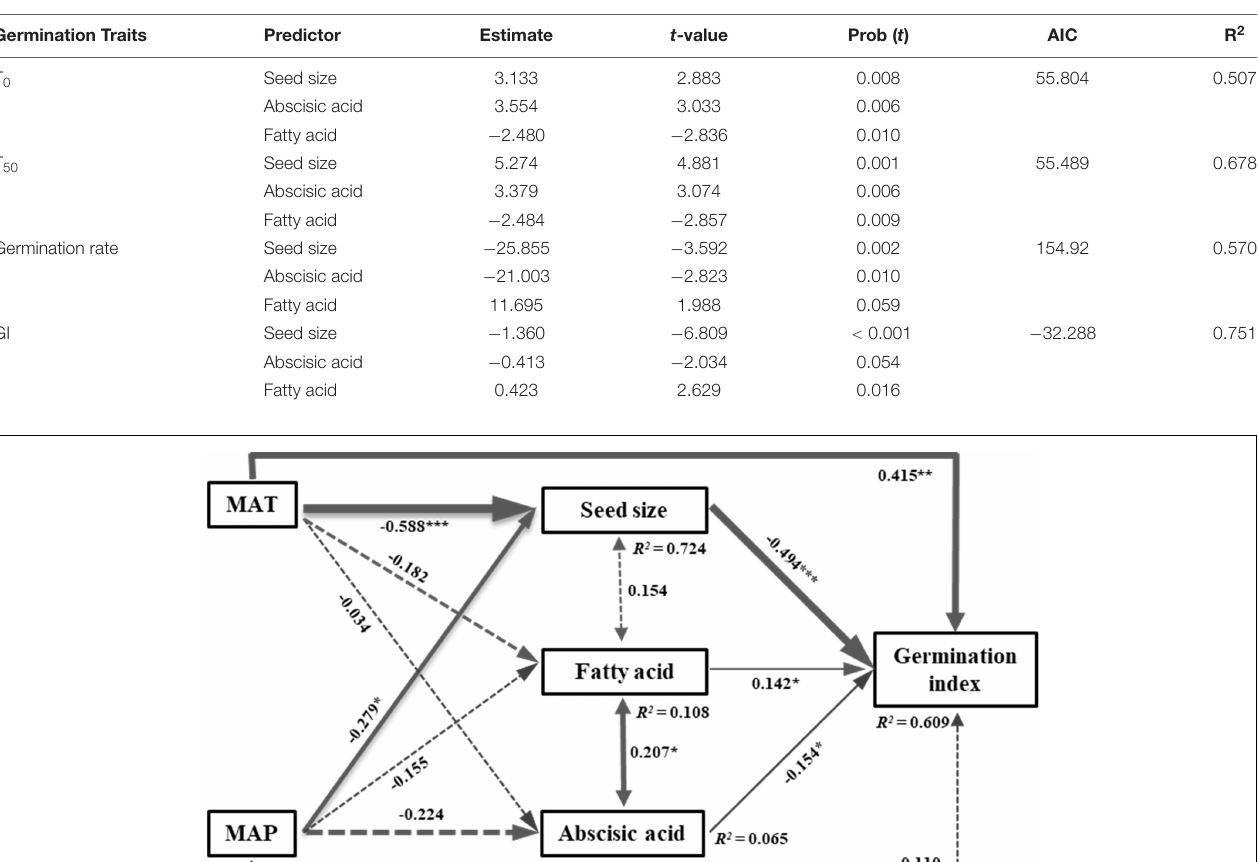
TABLE 3 | Effects of seed intrinsic traits on the seed germination traits of Ambrosia artemisiifolia from 26 populations.